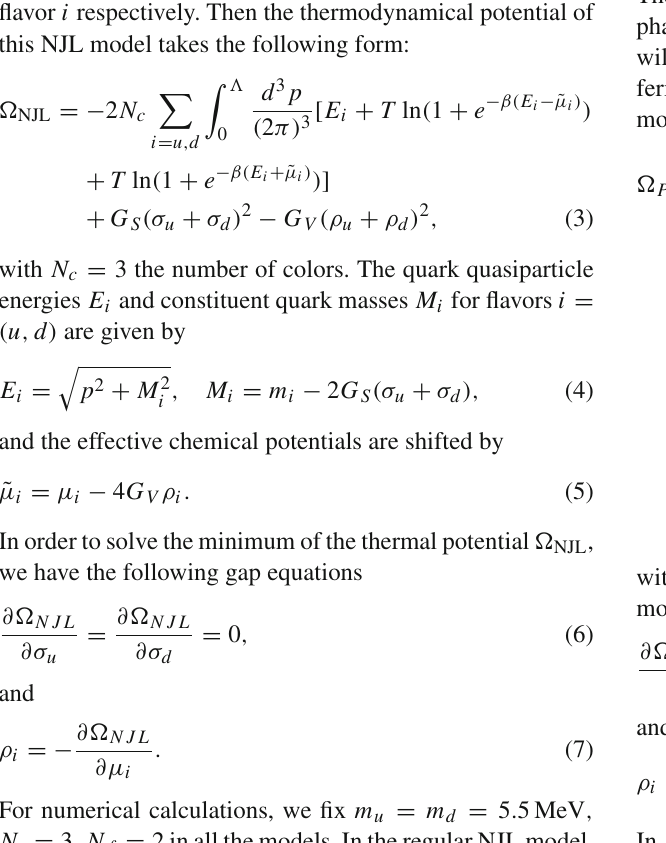
Table 2. For the PNJL-1, at zero chemical potential μ = 0, the critical temperature for the chiral phase transition χ = 222 . 9 MeV, and for deconfinement phase tran- is T 0 = 214 . 3 MeV, and the CEP is located at sition is T D 0 = 919 . 1 MeV , T E = 123 . 5 MeV ) . For the PNJL-2, (μ E B at μ = 0, the critical temperature for the chiral phase tran- χ = 223 . 6 MeV, and for deconfinement phase sition is T 0 = 215 . 0 MeV, and the CEP is located at transition is T D 0